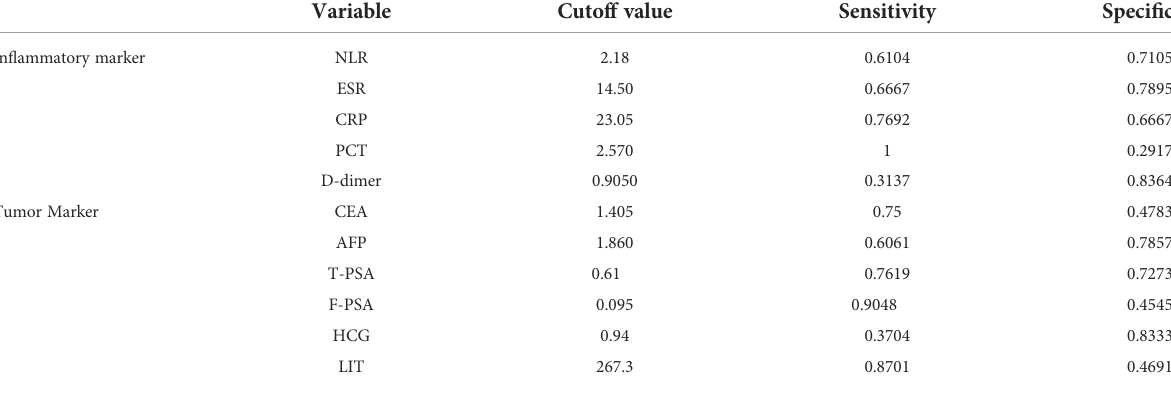
TABLE 6 Sensitivity and speci fi city of LIT and conventional cancer diagnostic